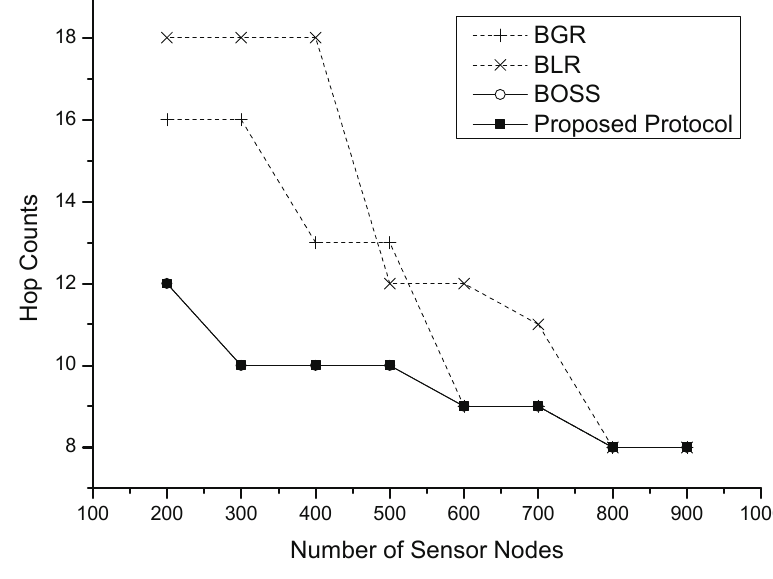
Figure 8. The hop counts vs. the number of sensor